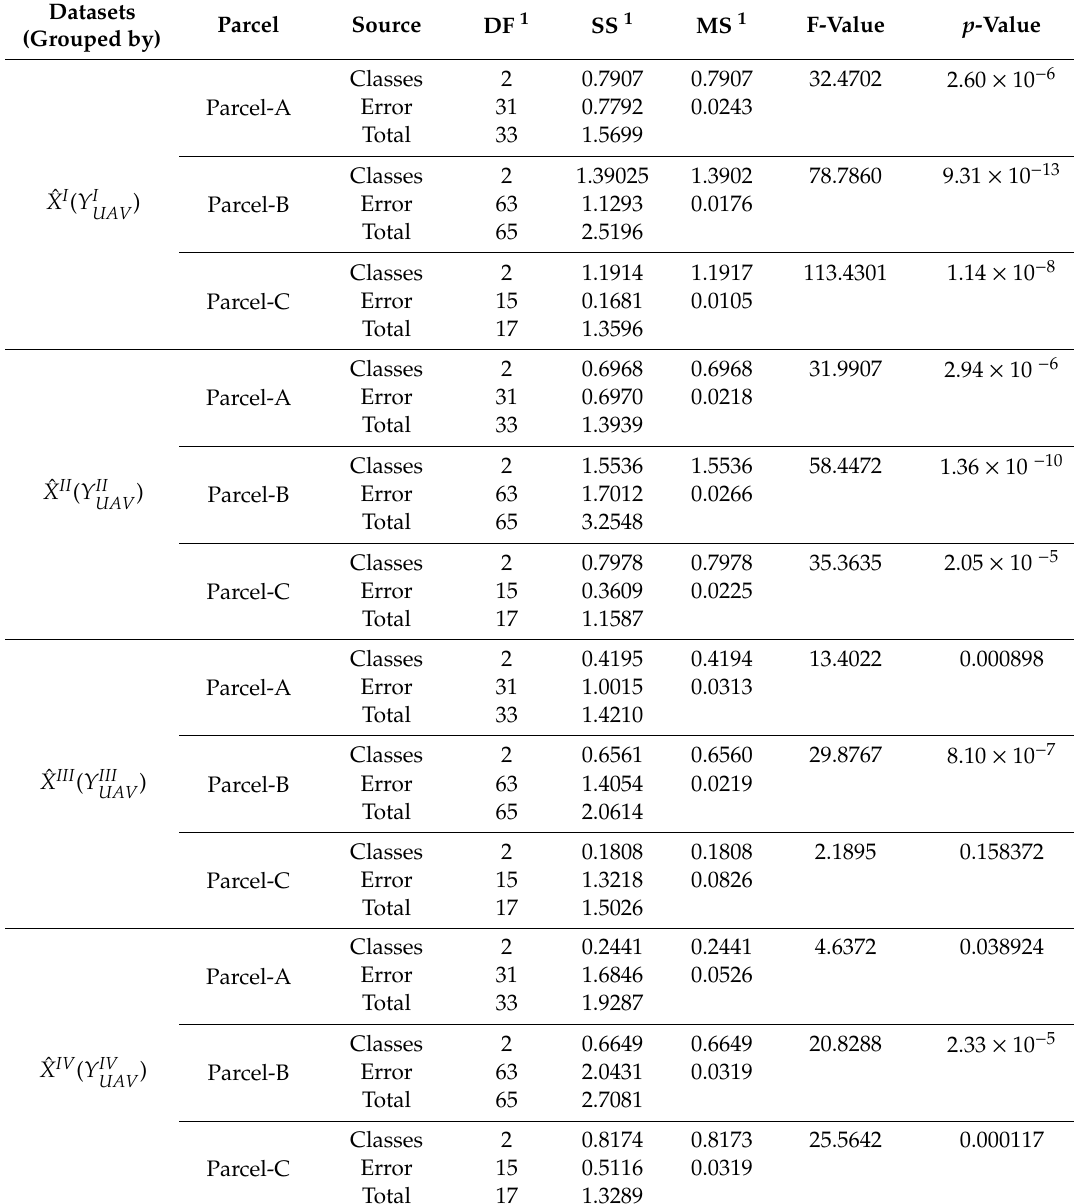
Table 4. ANOVA results of refined datasets ˆ X I , ˆ X II , ˆ X III , and ˆ X IV , grouped according to